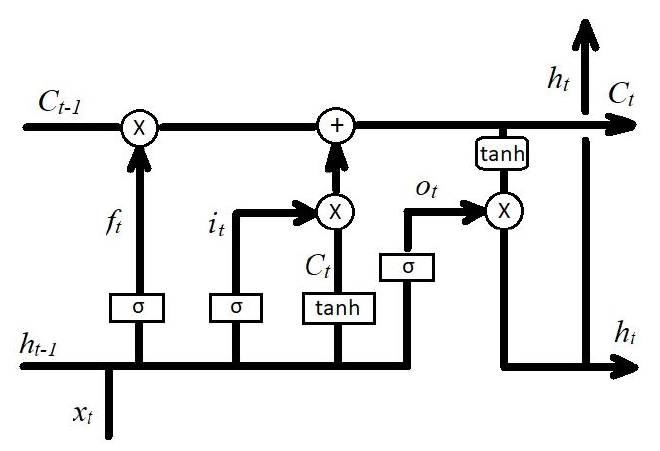
Figure 6. Architecture of long short-term memory networks (LSTM) network nodes [12].